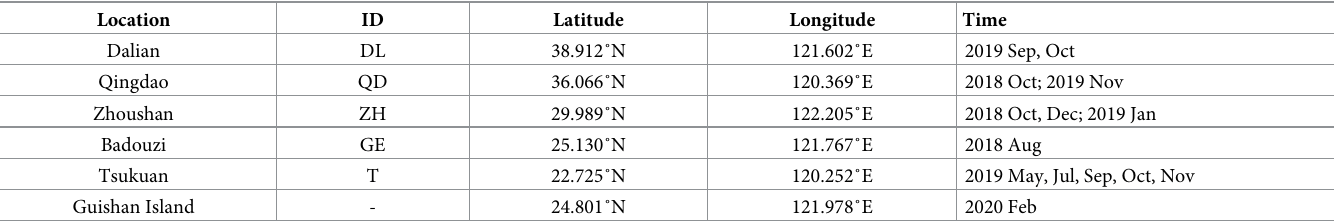
Table 1. Sampling location and time of T . japonicus specimens collected in this